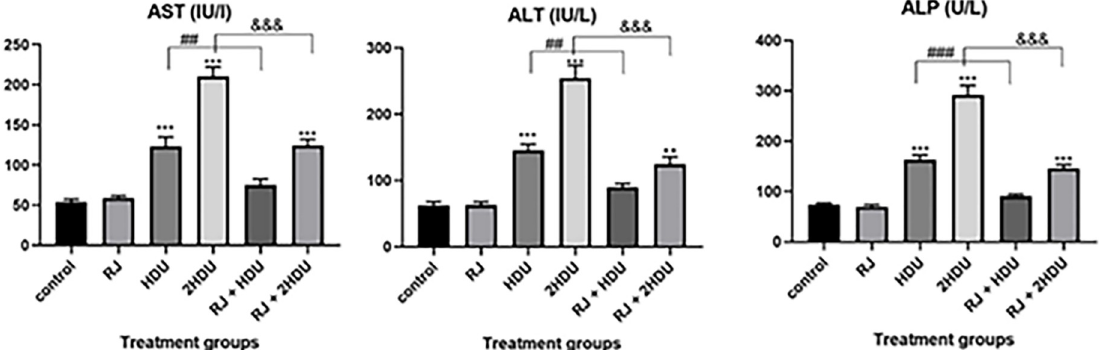
Fig 3. Effects of oral royal jelly (RJ; 100 mg/kg bwt) administration on serum aspartate aminotransferase (AST), alanine aminotransferase (ALT), and alkaline phosphatase (ALP) levels in rats treated with hydroxyurea (HDU; 225 or 450 mg/kg bwt) for 60 days. Data are presented as the mean ± SEM. Compared to the control, significance at (p < 0.01) �� and (p < 0.001) ��� (ANOVA with Dunnett’s multiple comparison test). Compared to HDU treated groups using Unpaired t-test, significance at p < 0.001 ### and &&& for HDU and 2HDU groups,